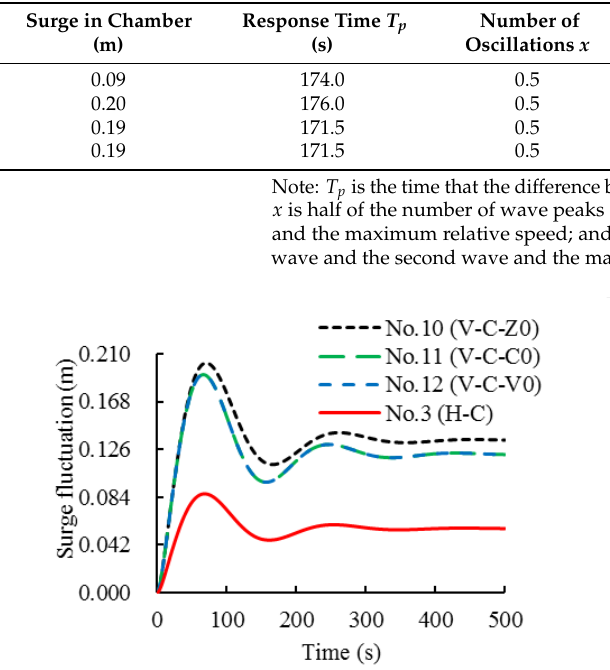
Table 7. Numerical Results under SLD conditions.